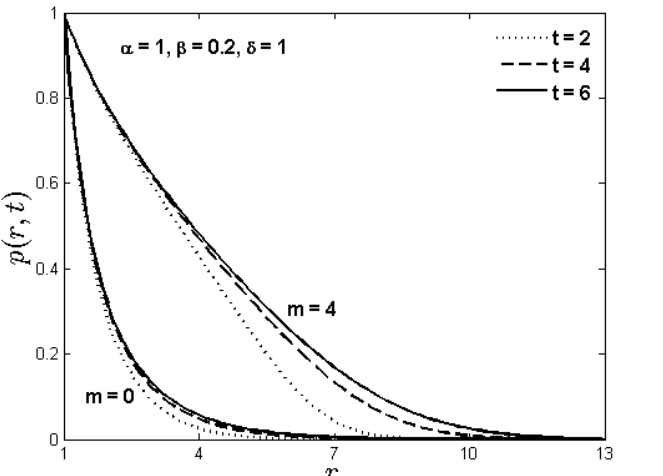
Figure 2. Fluid pressure as a function of radial distance for various values of time t and permeability parameter m